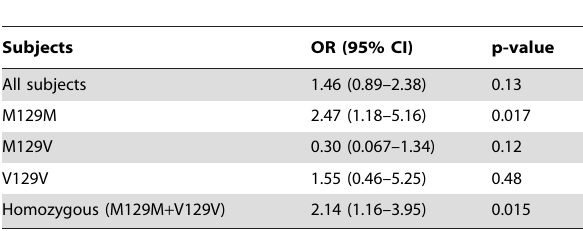
Table 6. Odds ratios for the association between CJD and APOE e 4 carriers (vs. APOE e 4 non-carriers) among different strata defined by PRNP codon 129 genotypes.